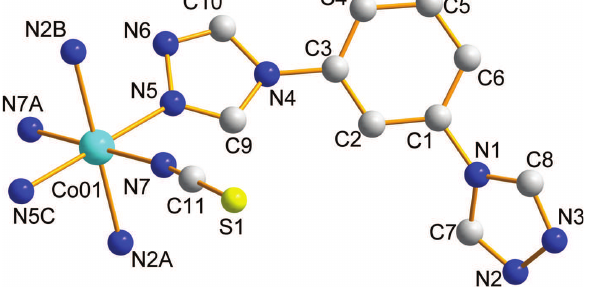
Table 1: Data collection and handling.